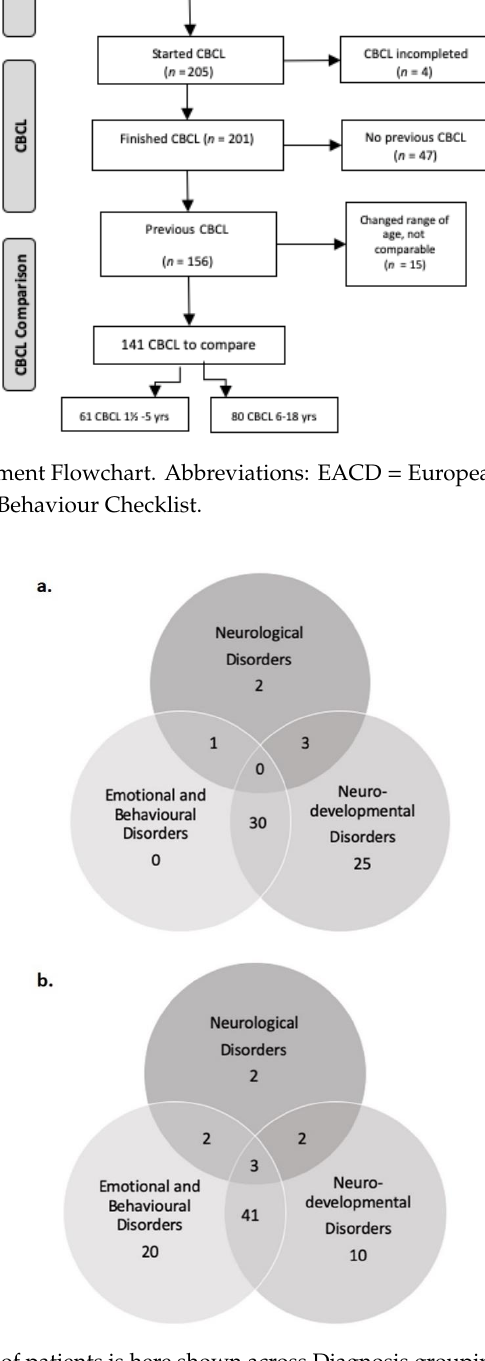
Figure 2. The distribution of patients is here shown across Diagnosis grouping for ( a ) CBCL—1.5/5 and ( b )